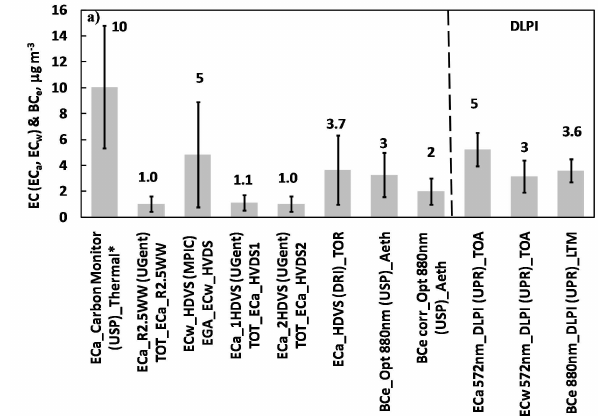
Fig. 5. (a) Comparison of EC (EC a and EC w ) and BC e averages for D p < 2 . 5µm using the carbon monitor, HVDS (MIPC), 1HVDS (UGent), 2HVDS (UGent), Aethalometer (at 880nm), and the DLPI together with the standard deviation bars. Only for the aethalome- ter is D p < 10µm. EC a refers to non-extracted thermal samples and EC w refers to water extracted samples using thermal, TOA, and TOT methods. BC e Opt 880nm refers to the species measured by the aethalometer at 880nm, and BC e corr Opt 880nm refers to the species measured by the aethalometer at 880nm and corrected for filter loading and multiple scattering (Weingartner et al., 2003; Schmid et al., 2006). BC e 880nm DLPI refers to the species mea- sured by the light transmission method at 880nm and determined using a σ = 16 . 6m 2 g − 1